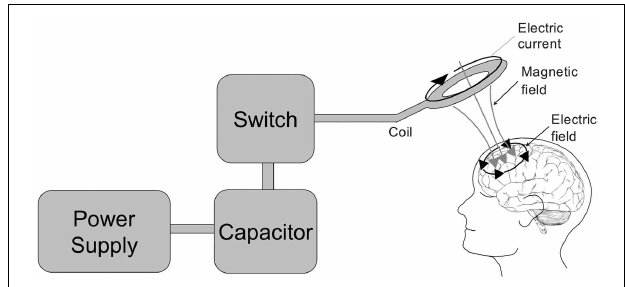
FIGURE 3 |The transcranial magnetic stimulator . A block diagram depicting the transcranial magnetic stimulator circuit is depicted on the left. The power supply charges the capacitor. An operator or computer then signals for the charge stored in the capacitor to be released into the stimulation coil through a thyristor switch.The current flowing through the stimulating coil (here depicted as a circular coil) produces a perpendicular magnetic field which transverses the skull and induces electrical currents within the cortex underlying the coil.